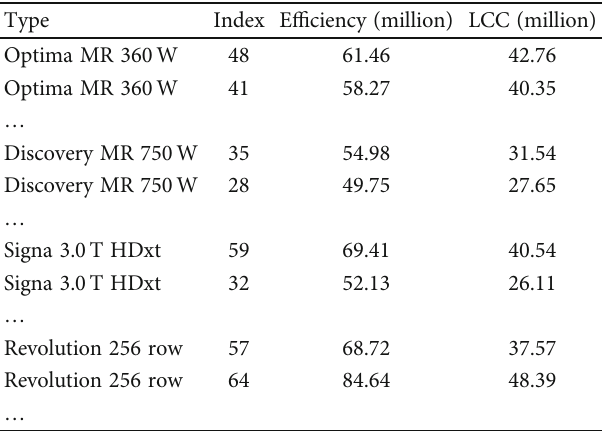
Table 2: E ffi ciency value and LCC value excerpts of equipment.